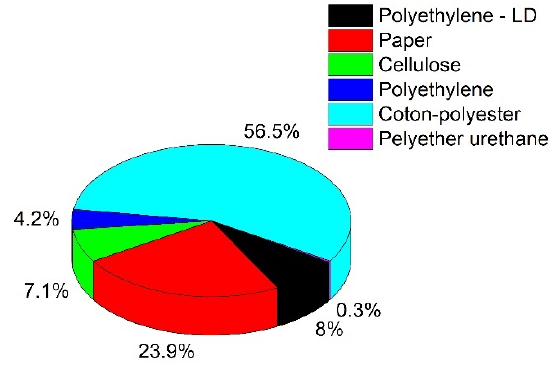
Figure 2. Composition of LA representative sample. Table 2. Composition of reference and LA dosed